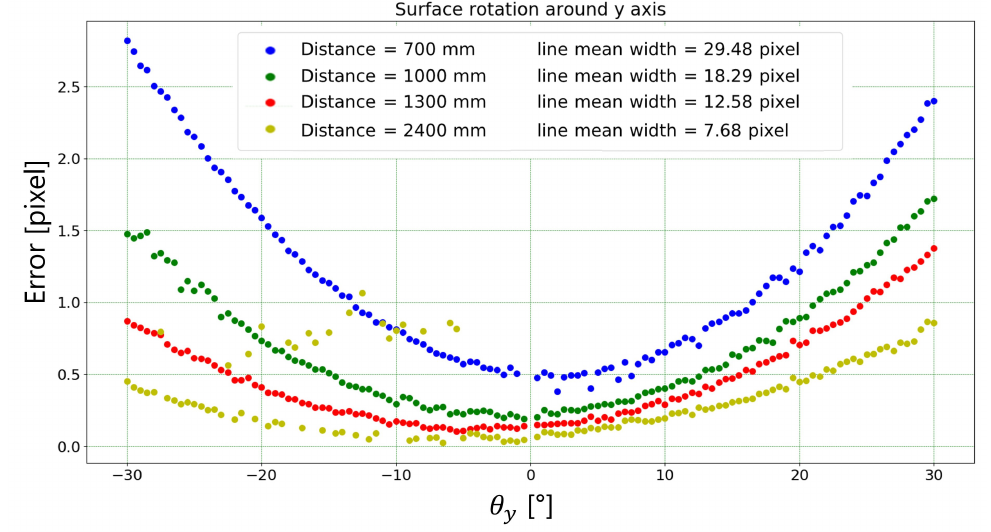
Figure 20. Absolute error (i.e., difference between mean width measured by the proposed algo- rithm and the target width) in pixels for each rotation angle (around y axis) and each working distance